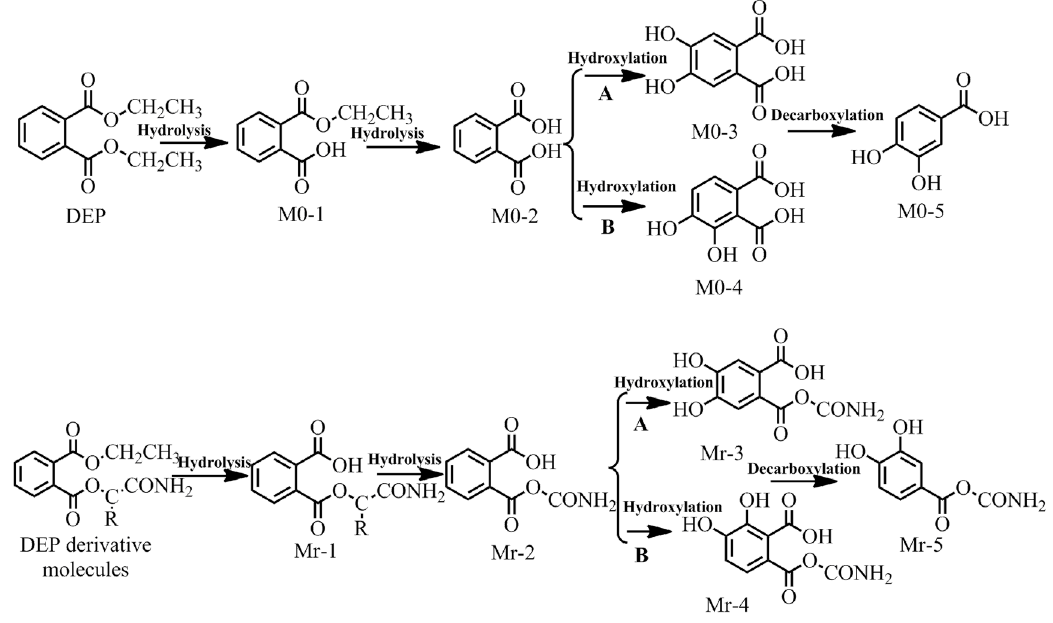
Figure 4. Schematic diagram of transformation paths of microbial degradation of DEP and its derivative molecules. A: The transformation path of gram-negative bacteria; B: the transformation path of Gram-positive bacteria; M0: the microbial degradation products of DEP; Mr: the microbial degradation products of DEP derivative molecules; R: -CH 3 , -CH 2 CH 3 , -CH (CH 3 ) 2 ; r = 1, 2, 3. Table 6. Calculation of the reaction energy barrier of microbial degradation transformation paths of DEP and its derivatives.